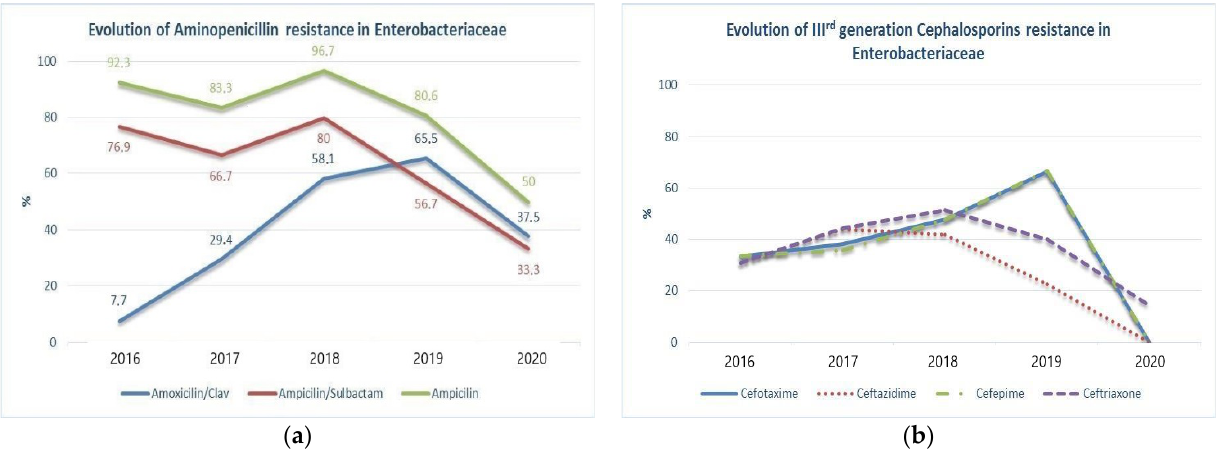
Figure 1. ( a ) Evolution of amoxicillin/clavulanic acid, ampicillin/sulbactam, and ampicillin resistance in Enterobacteriaceae ( p < 0.001) causing UTI in children with CAKUT; ( b ) evolution of cefepime, cefotaxime, ceftazidime and ceftriaxone resistance in Enterobacteriaceae causing UTI in children with CAKUT.